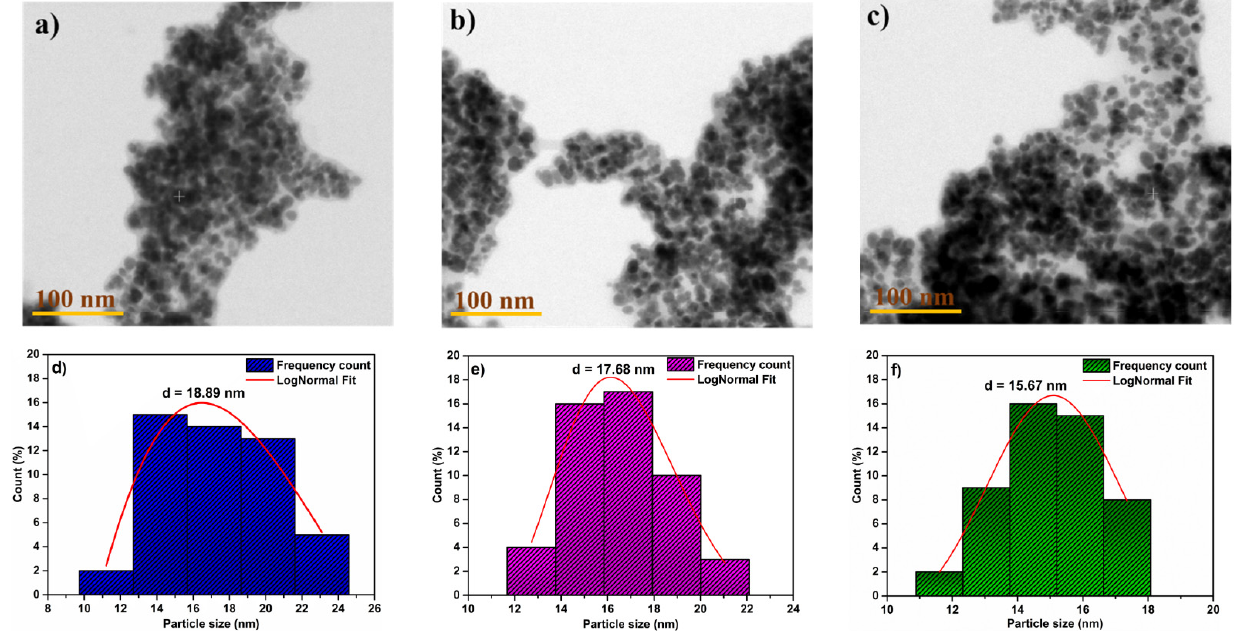
Figure 8. STEM images: ( a ) MNP-P; ( b ) MNP-P-FA1; ( c ) MNP-P-FA2 and histograms of particle size distribution: ( d ) MNP-P; ( e ) MNP-P-FA1; ( f ) MNP-P-FA2.